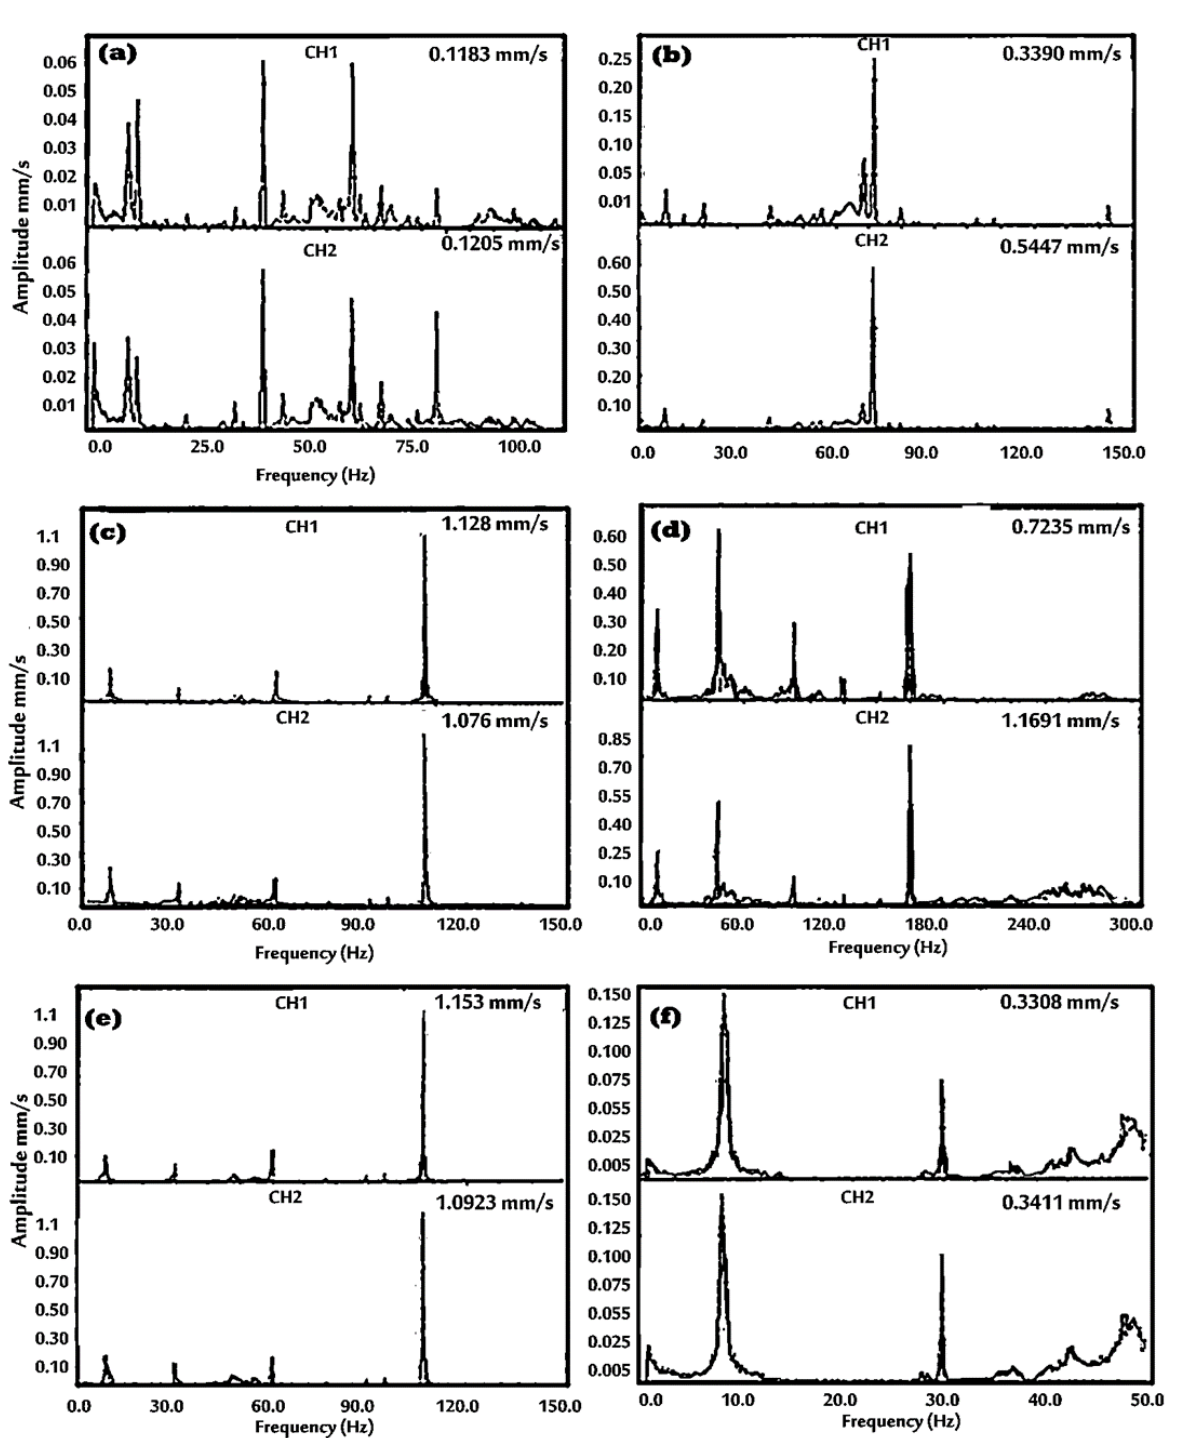
Figure 16. Autospectrum vibration response of the wind tunnel structure at the inlet (channel 1-CH1) and exit (channel 2-CH2) ( a – e ) is the frequency domain signature for 10, 20, 30, 40, and 50 Hz fan frequencies, and ( f ) the bump test response.